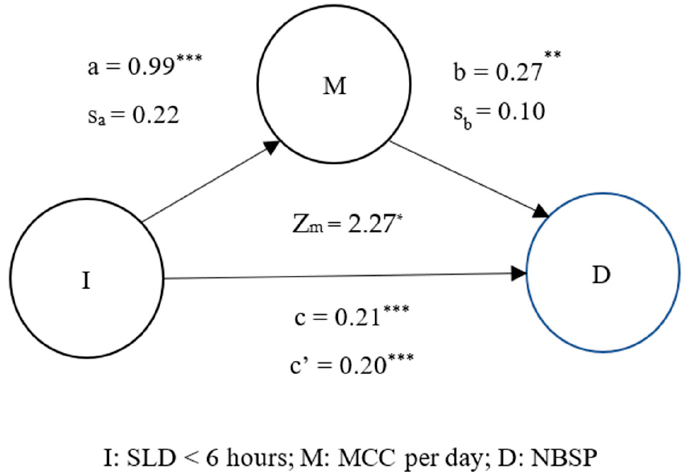
Figure 1. Mediation effect of MCC per day on SLD < 6 h and NBSP. * p < 0.05; ** p < 0.01; *** p < 0.0001; M, mediation factor; I, independent variable; D, dependent variable.